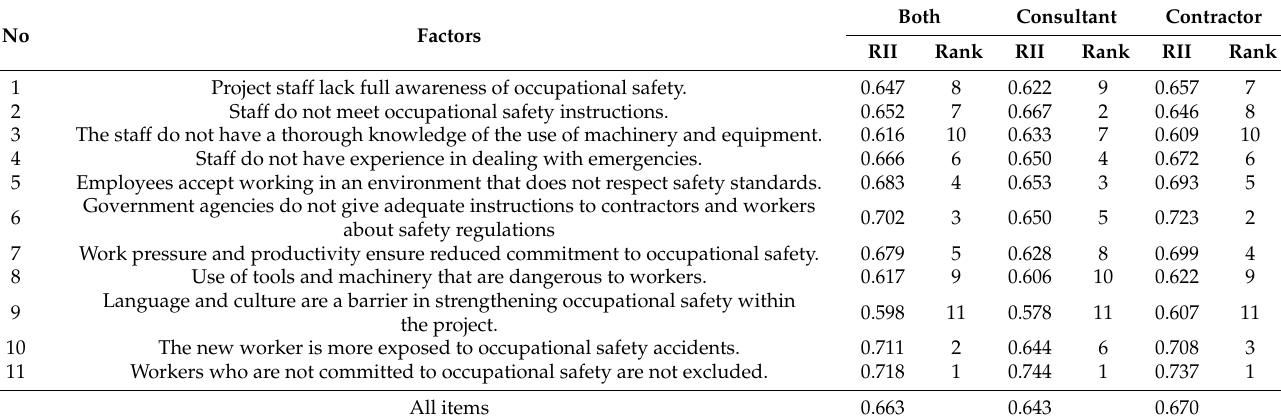
Table 7. Rank and RII of items related to behavioral and cultural